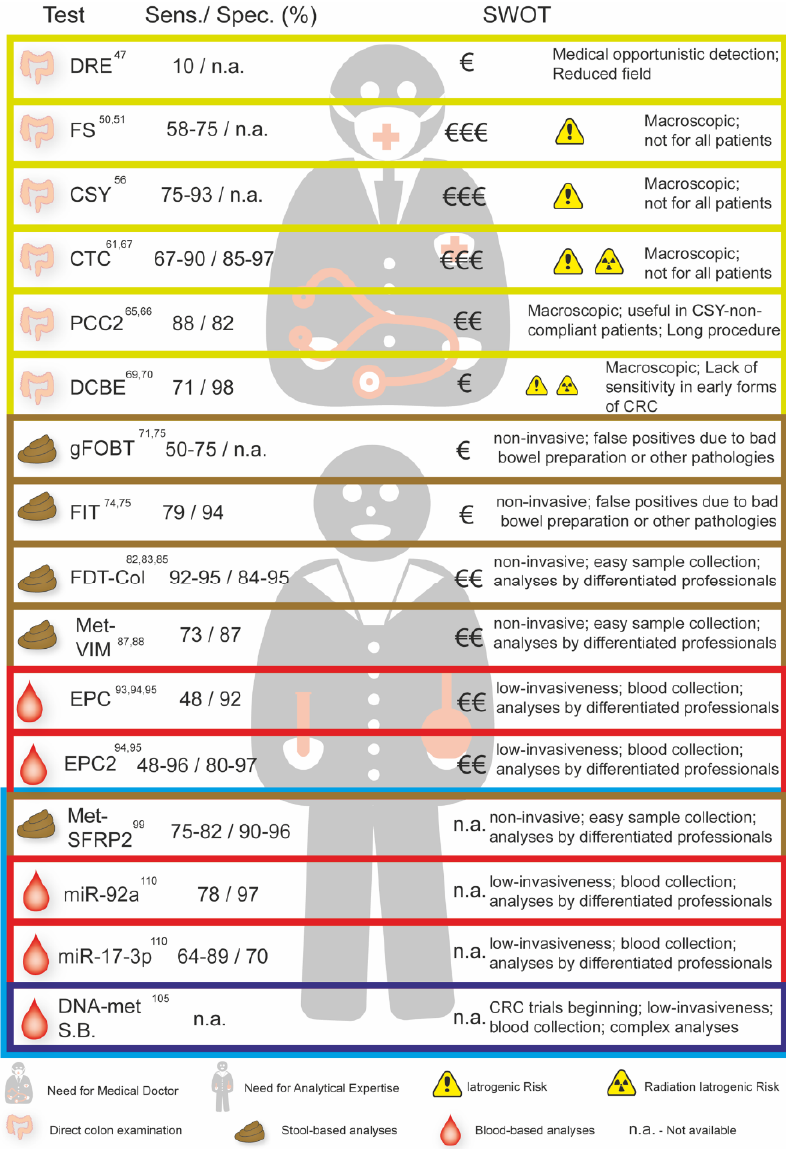
DNA-met S.B.—Blood Based DNA Methylation Beginning Trials.